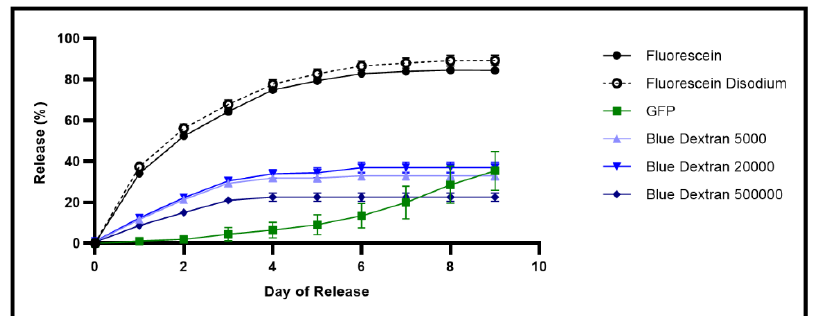
Figure 5. Release profiles of six different model drugs: fluorescein, fluorescein disodium, GFP, and blue dextran with molecular weights of 5000, 20,000, and 50,000 g/mol, from the hydrogels. A one- way ANOVA was used to compare release of the different model drugs each day, with no significant difference between the release of blue dextran with a molecular weight of 5000 and 20,000 g/mol any of the days, and no significant difference between the release of fluorescein and fluorescein disodium starting on day 3. All the other model drugs had significantly different release profiles until day 7, where the release for GFP and blue dextran 500,000 g/mol are not significantly different; day 8 where GFP release is not significantly different from any of the blue dextran release and blue dextran 5000 g/mol is not significantly different from 500,000 g/mol; and day 9 where GFP release is not significantly different from blue dextran with a molecular weight of 5000 and 20,000 g/mol, and blue dextran 5000 g/mol is not significantly different from 500,000 g/mol (Table S5).